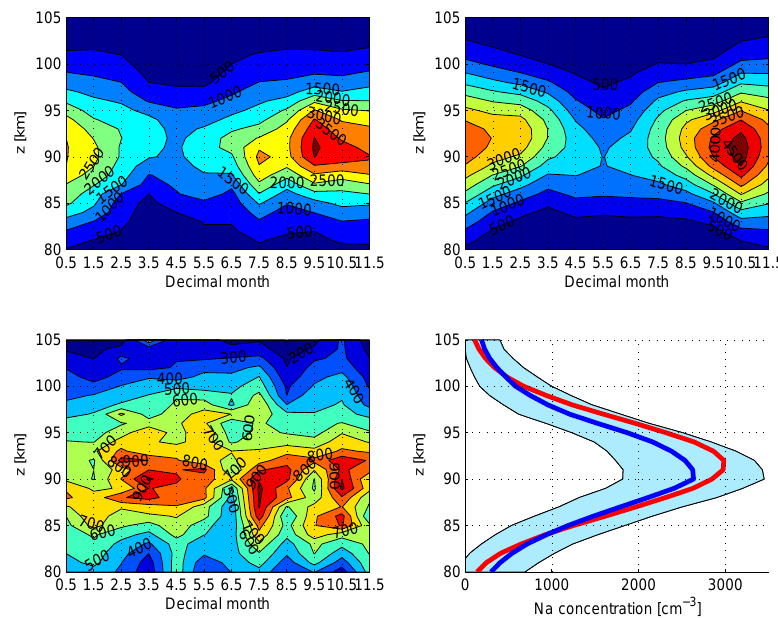
Fig. 8. Top left: time-altitude Na concentration profiles (cm − 3 ) measured by GOMOS in the 30 ◦ –50 ◦ latitude band. Top right: Fort Collins Na climatology (1990–1991) at 41 ◦ N. Bottom left: GOMOS measured uncertainty. Bottom right: blue: GOMOS annual mean in the 30 ◦ –50 ◦ latitude band with the associated uncertainty envelope; red: Fort Collins annual mean profile.